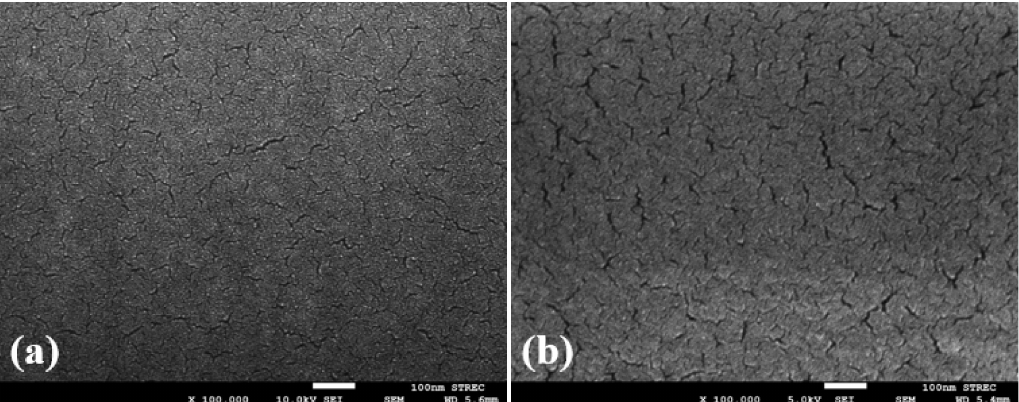
Figure 5. FESEM images of ( a ) NIP and ( b ) IPA–MIP.